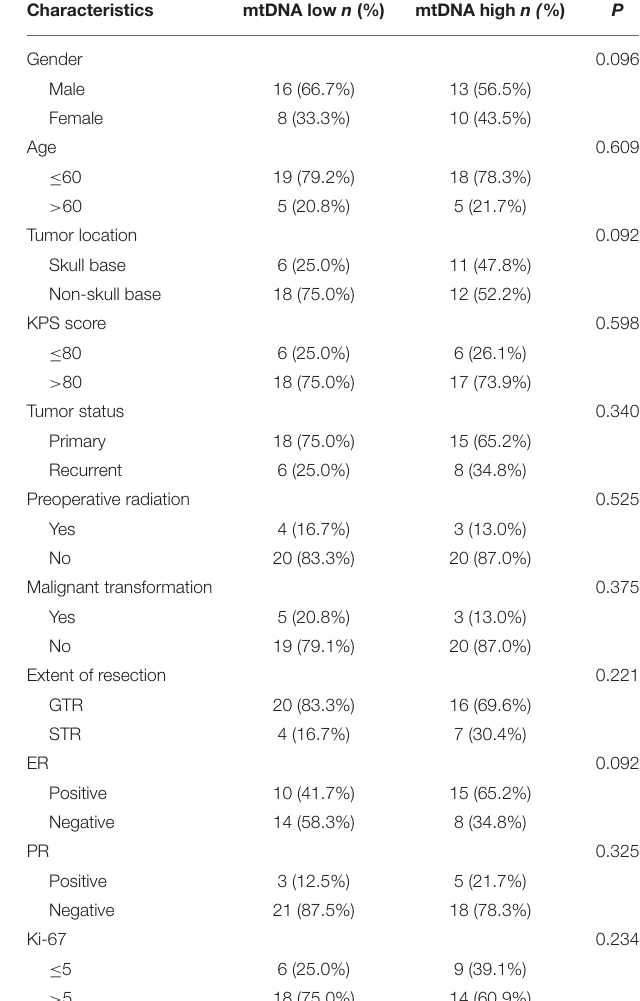
TABLE 3 | Association between mtDNA content and clinical-pathological variables of Grade III meningioma patients who receive post-operative radiation therapy.